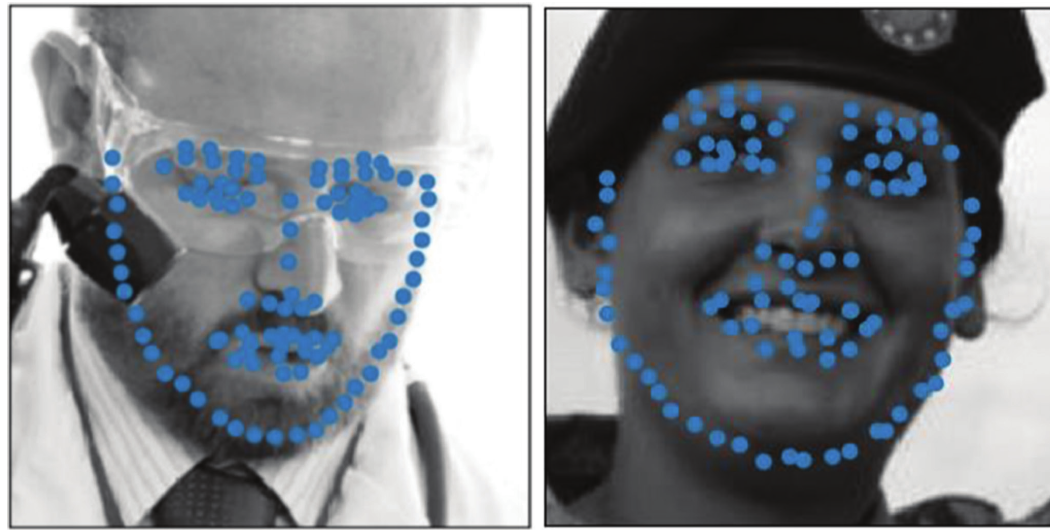
Figure 3 Example of face images with detected key points.